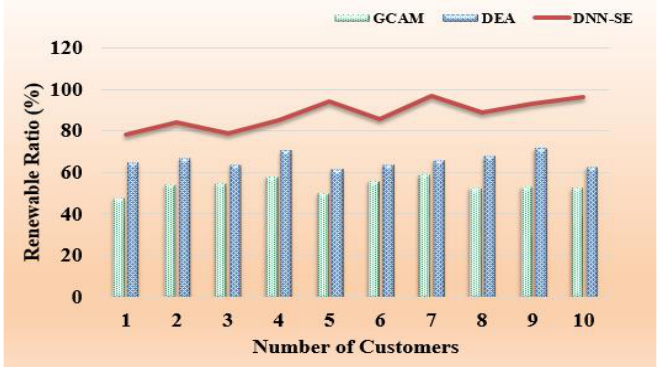
Figure 9. Renewable energy